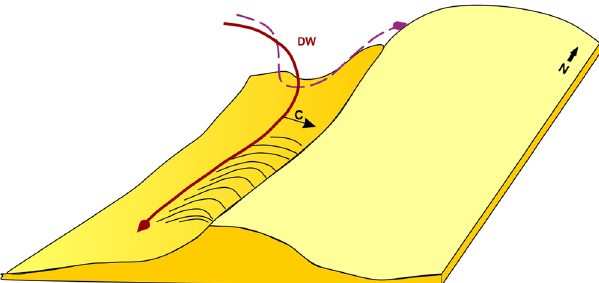
Fig. 4 Conceptual model showing formation of the sediment drift on the ASE shelf. Upwelled deep water DW (red arrow) fl ows southwards into the trough in the shelf break and then is steered by the eastward rising sea fl oor carrying/picking up sedimentary material. The DW is then de fl ected to the left in relation to the fl ow direction due to Coriolis effect (black arrow C) 33,34 . There, the fl ow velocity is reduced and the material is deposited thus forming a plastered sediment drift against the sloping sea fl oor. With the onset of cooling, deep water is upwelled less vigorously only into the outer trough (purple dashed arrow) and then fl ows back into the deeper